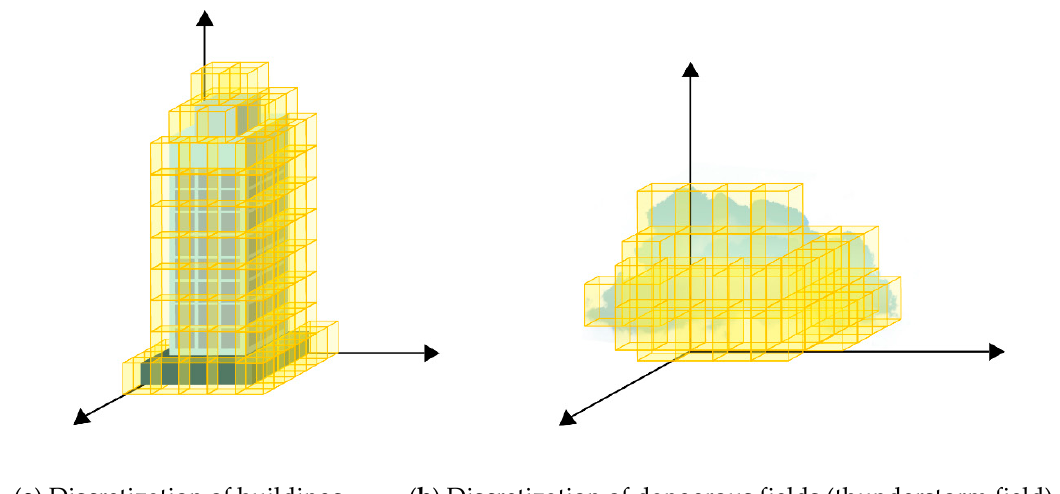
Figure 5. Subdivisions of volume elements and dangerous fields.